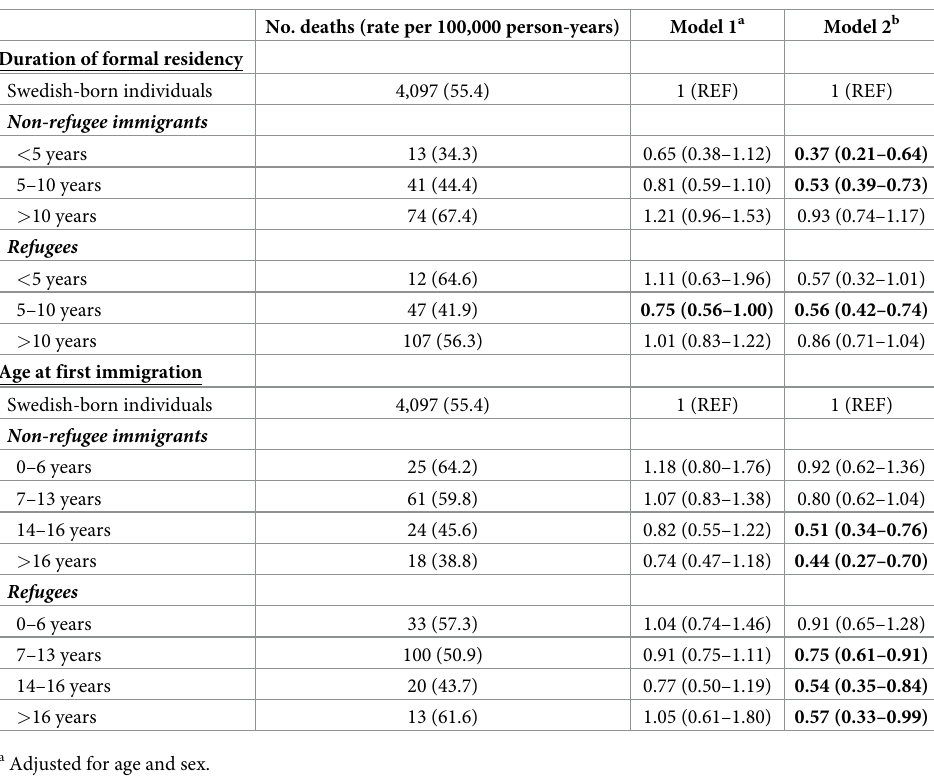
Table 4. Risk of all-cause mortality by refugee status, duration of formal residency in Sweden, and age at first immigration respectively. Individuals aged 19–25 years old residing in Sweden in 2004. Hazard ratios (HRs) with 95% confidence intervals